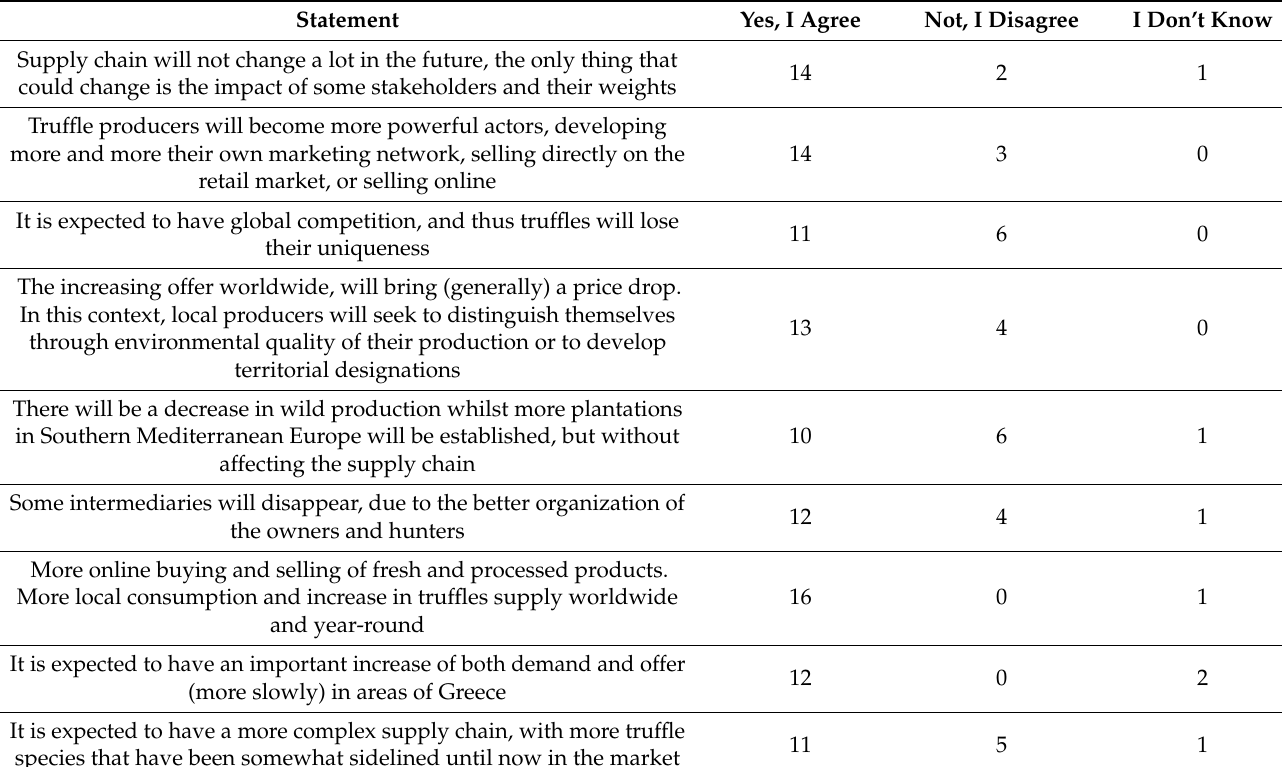
Table 1. Forecast of the future of the truffle supply chain by the expert panel. The table summarizes the total number of responses (agree/disagree/not answer) of the 17 panelists to the question: How the supply chain will change in the next decade in Mediterranean Europe (Italy, Spain, France, Croatia,